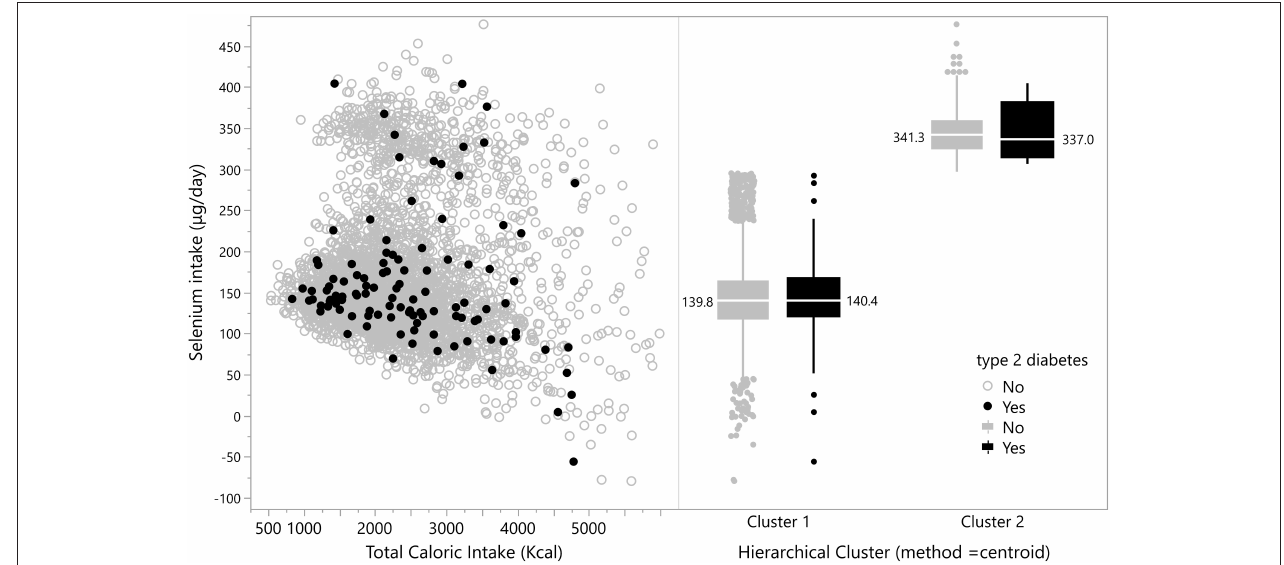
FIGURE 1 | Distribution of participants according to energy-adjusted Se intake and T2D prevalence.